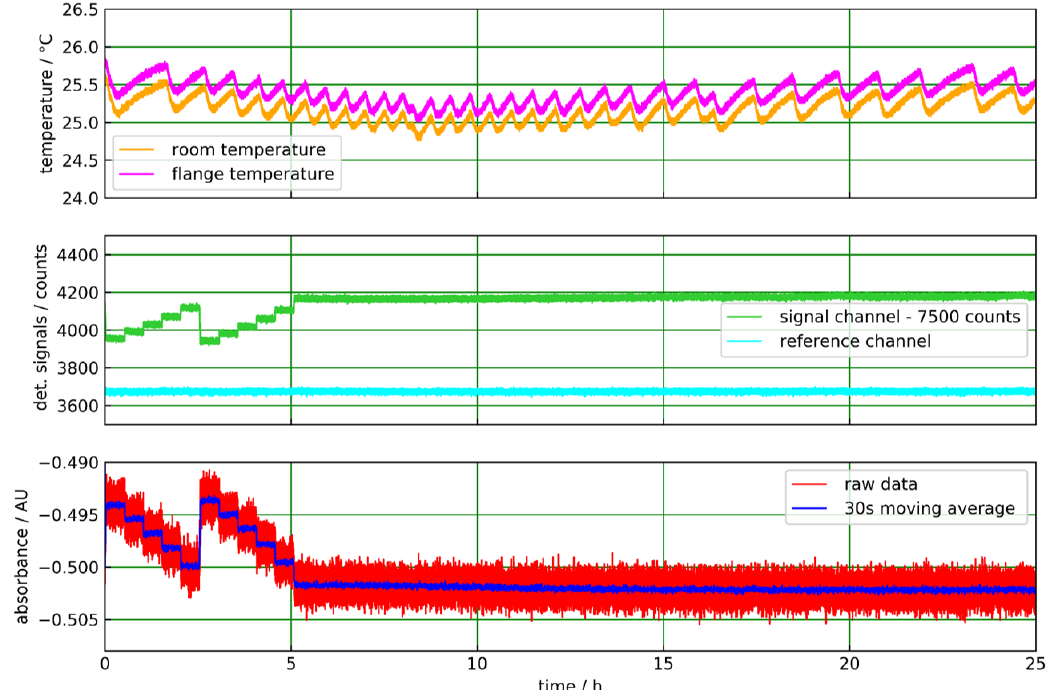
Figure 7. ATR measurement of pure CO 2 gas with the sapphire tube in transmission geometry (Figure 6b). Ambient and flange temperatures show a sawtooth-like modulation between 25 and 26 ◦ C, which is caused by the lab temperature control. ( top ). The detector signal channel ( middle ) shows characteristic steps when the CO 2 pressure is varied in 1-bar steps from 5 bar absolute pressure to ambient pressure. After 5 h, a purge flow of N 2 at ambient pressure sets in. The reference channel is not affected by the pressure variations and stays almost constant. In the absorbance plot the pressure steps are well resolved ( bottom ).